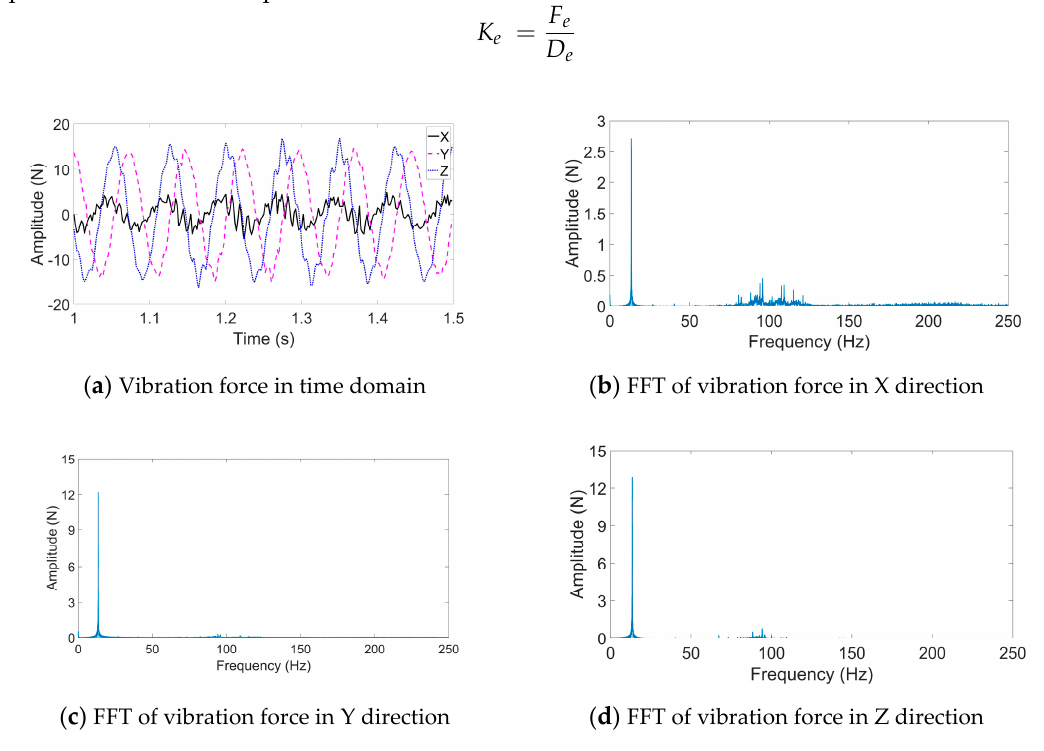
Figure 4. Interface of PULSE software in the vibration measurement.